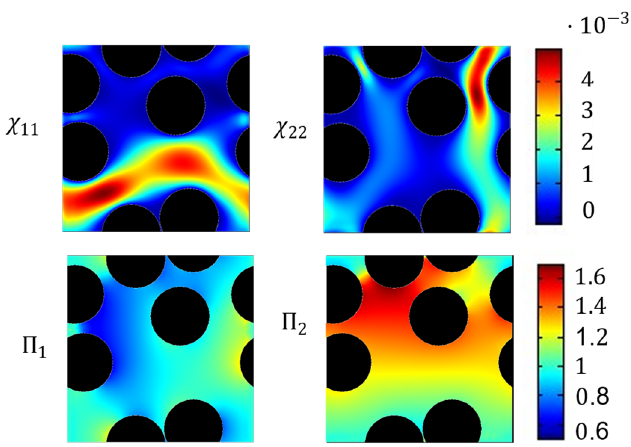
Figure 5. Base functions of the cell problem for convection in the RVE geometry with five fibers. On the left side, the corresponding base functions to the y 1 -direction, and on the right side to the y 2 -direction. Top : Base functions velocity χ ij . Bottom : Base functions pressure Π j .